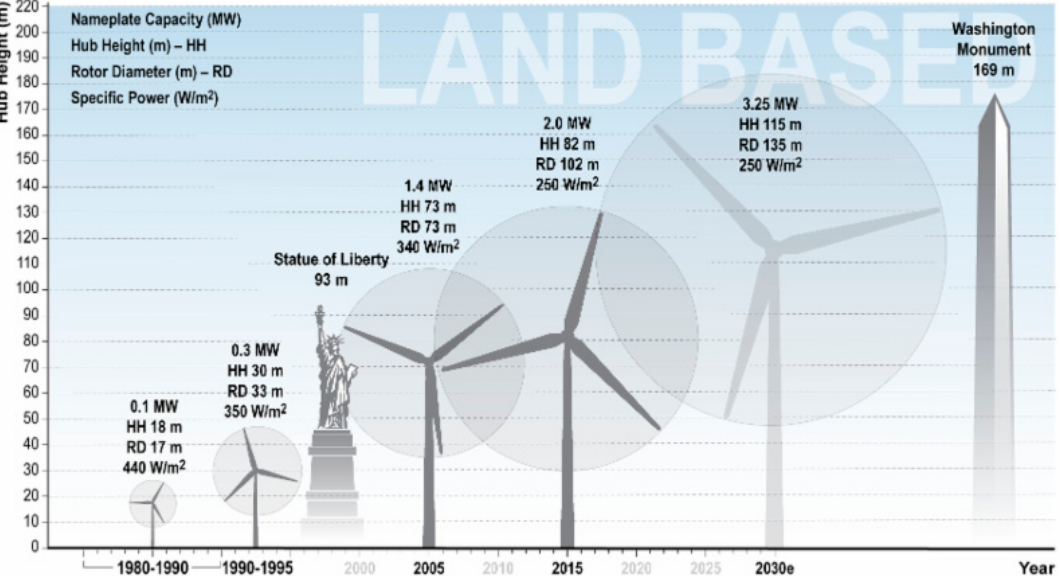
Figure6. Windturbinehistoricalheightandfutureprojections. Source: Figure 6. Wind turbine historical height and future projections. Source: Berkeley National Laboratory [121].